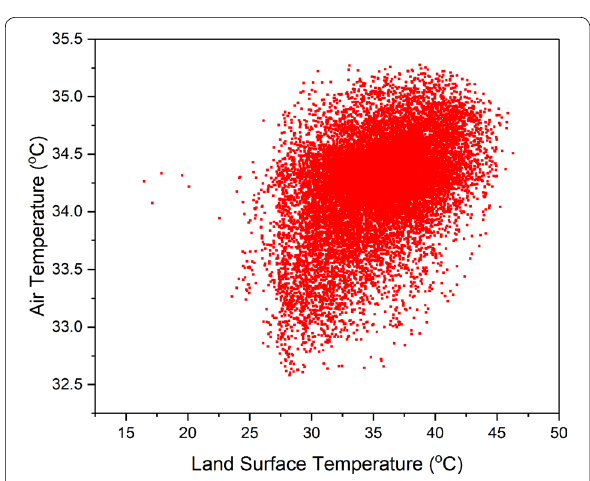
Fig. 5 Comparison of ADMS outputs and LSTs resampled in the same